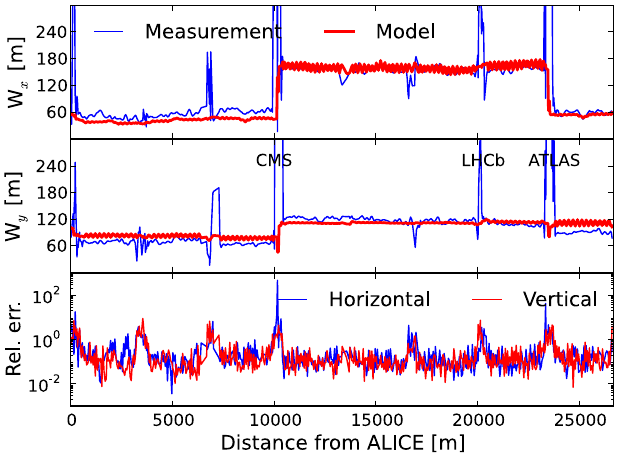
FIG. 12. Beam 1 horizontal (upper) and vertical (middle) Montague functions as defined in Eq. (3). The model function is shown in red, and the measurement in blue. The relative error of the measurements is shown in the lower plot. The figure shows the case for 0.6 m (cid:1) (cid:1) optics at 4 TeV beam energy, after